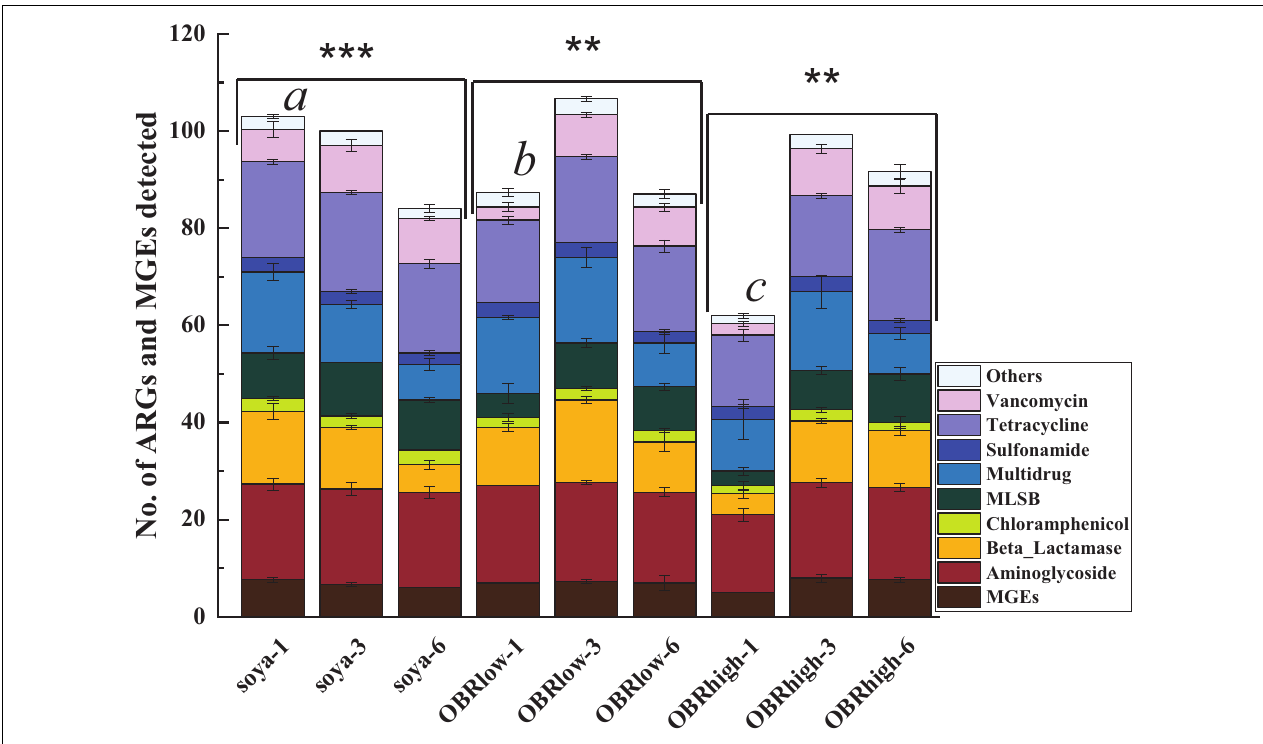
FIGURE 5 | Numbers of detected ARGs and MGEs (mean ± SE, n = 3). An ARG was considered detected when it was amplified in one sample; because many resistance genes were targeted by multiple primers, the detection of the same gene by multiple primer sets was counted as the detection of only a single unique resistance gene. “ ∗∗ ” and “ ∗∗∗ ” indicate P < 0.01 (among OBRlow groups and OBRhigh groups) and P < 0.001 (among soya groups), respectively. Different letters indicate significant differences ( P < 0.01, soya-1 vs. OBRlow-1 vs. OBRhigh-1). The soya, OBRlow, and OBRhigh represent treatments containing only soybean meal, a low amount of OBR, and a high amount of OBR, respectively, 1, 3, and 6 represent the first, third, and sixth day, respectively.